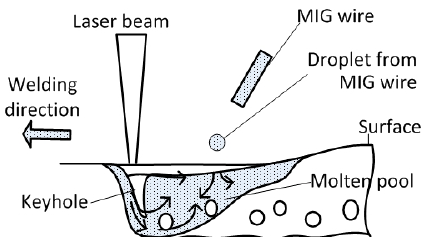
Figure 14. Experimental result of fluid flow for hybrid welding of aluminum alloy [8].